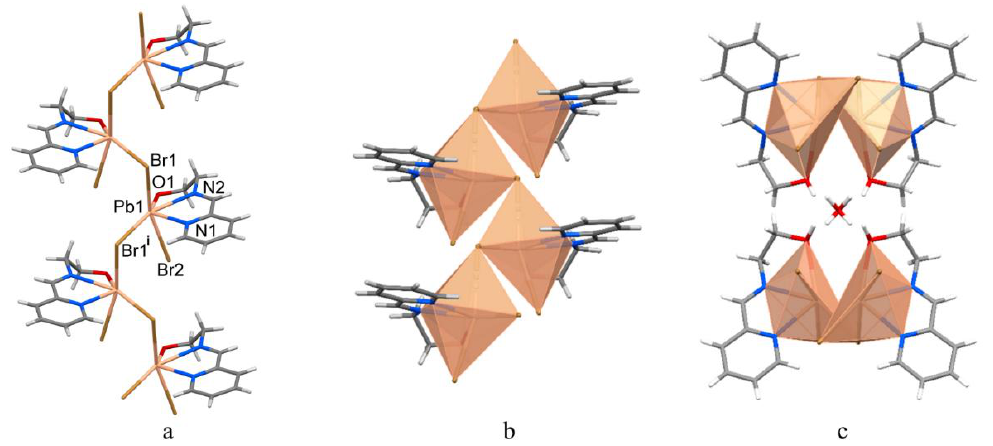
Figure 3. ( a ) Fragment of the double-side organically decorated bromoplumbate(II) chain in 2 [sym- metry code: i 1/2 − x , y , 1/2 + z ]; ( b ) polyhedral representation of the same fragment; ( c ) fragment of the crystal packing viewed down the c -axis showing spatial arrangement of two bromoplumbate(II) chains to form a hydrophilic channel filled with water molecules.